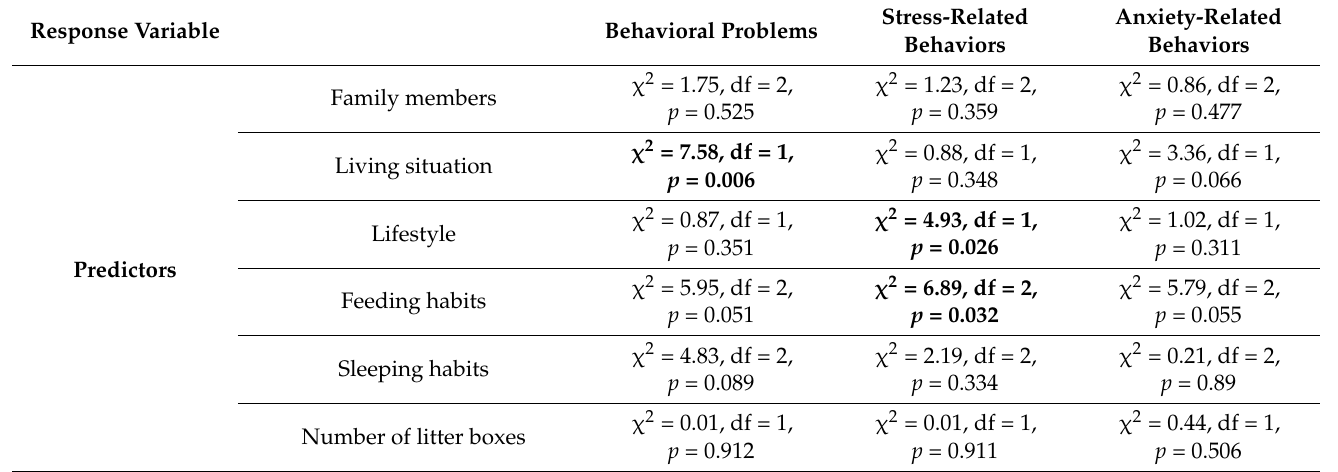
Table 5. Statistical outputs from linear mixed-effects models (LMMs) for cats (significant results ( p < 0.05) are in